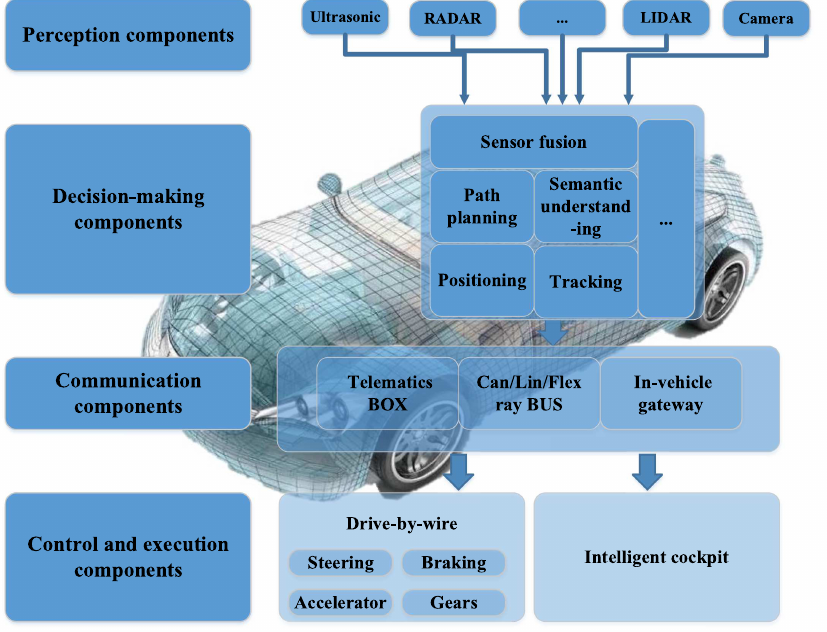
Figure 2. Typical E/E architecture for